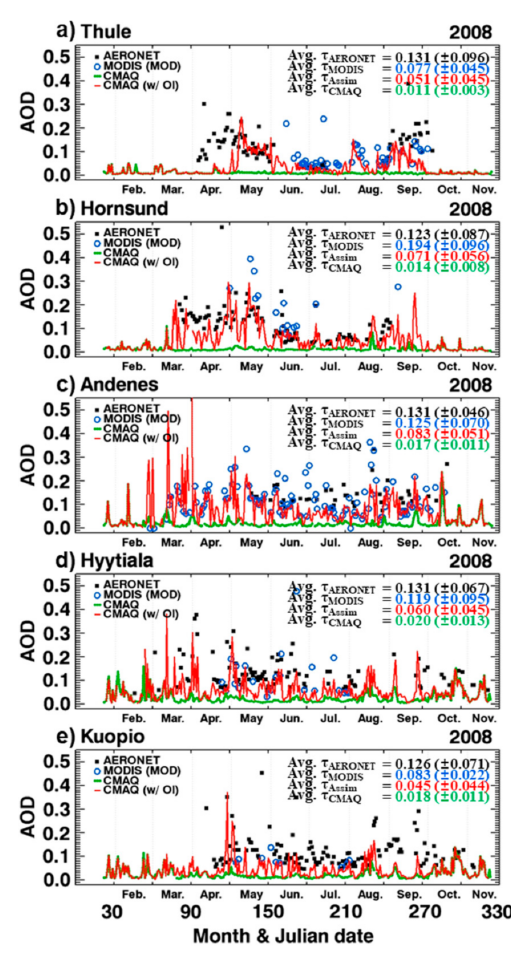
Figure 4. Daily mean variations of τ AERONET (black closed square), τ MODIS (blue open circles), τ CMAQ (green lines), and τ Assim (red lines) at several stations of ( a ) Thule, ( b ) Hornsund, ( c ) Andenes, ( d ) Hyytiala, and ( e ) Kuopio. Their mean values with standard deviations for